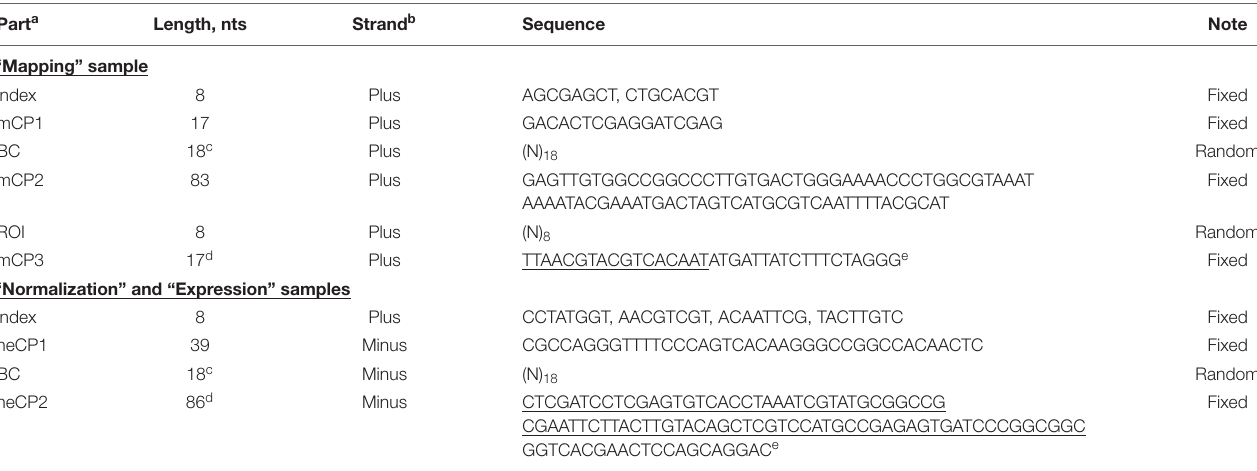
TABLE 1 | Specific features of the example MPRA data